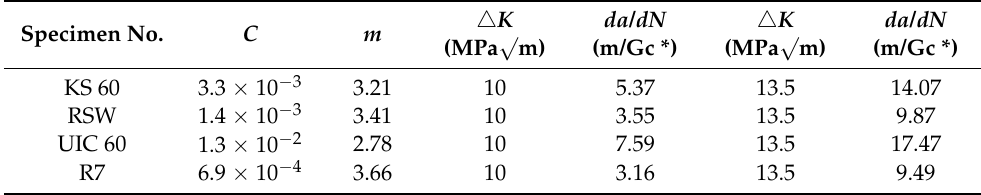
Figure 8. Fatigue crack growth rate test results. Table 4. FCGR characterizing